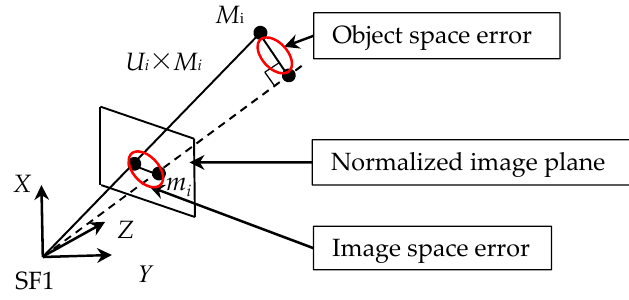
Figure 4. Image space error and the object space error.